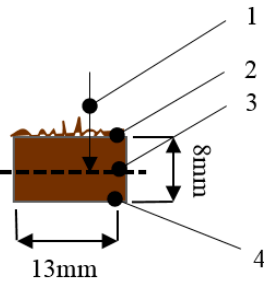
Figure 1. The scheme of the test sample for SEM imaging: 1—direction of investigation; 2—micro- organism-affected BcB surface; 3—the middle layer of the BcB sample; 4—the entire BcB